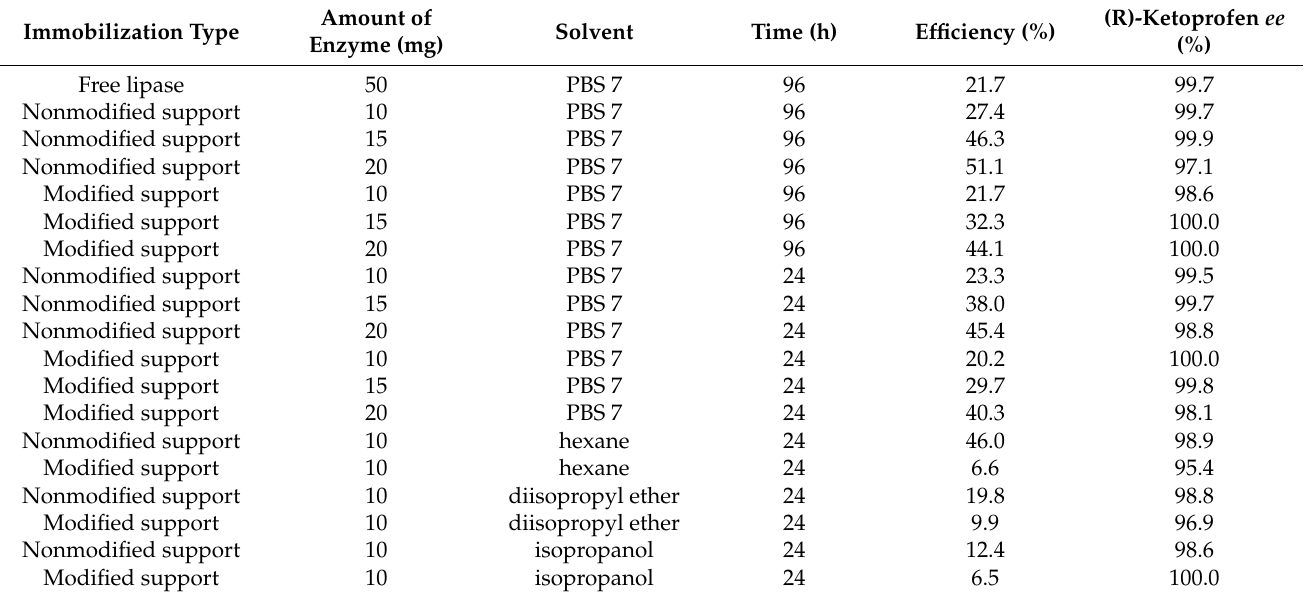
Table 4. The efficiency of the process after enzymatic conversion of ketoprofen methyl ester and enantiomeric excess (ee%) of (R)-ketoprofen over (S)-ketoprofen after 24 h and 96